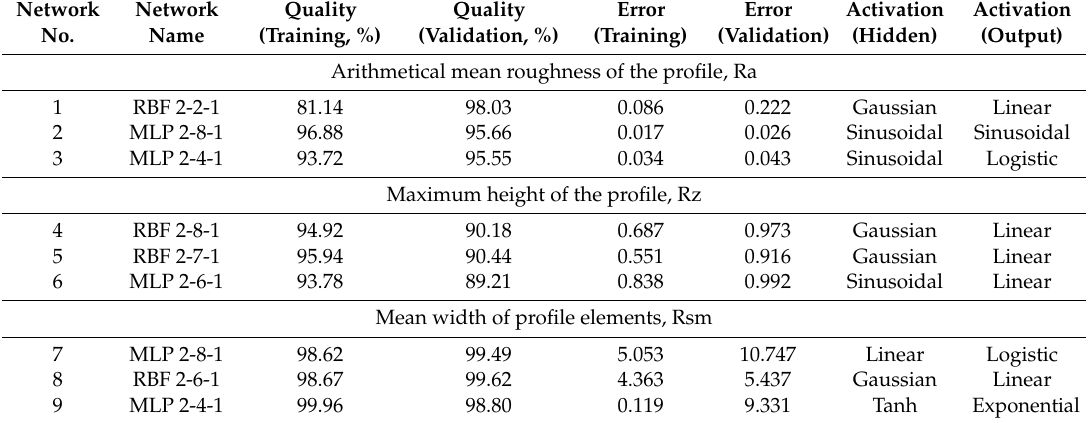
Table 5. Characteristics of MLP and RBF networks for surface roughness parameters Ra, Rz, and RSm.